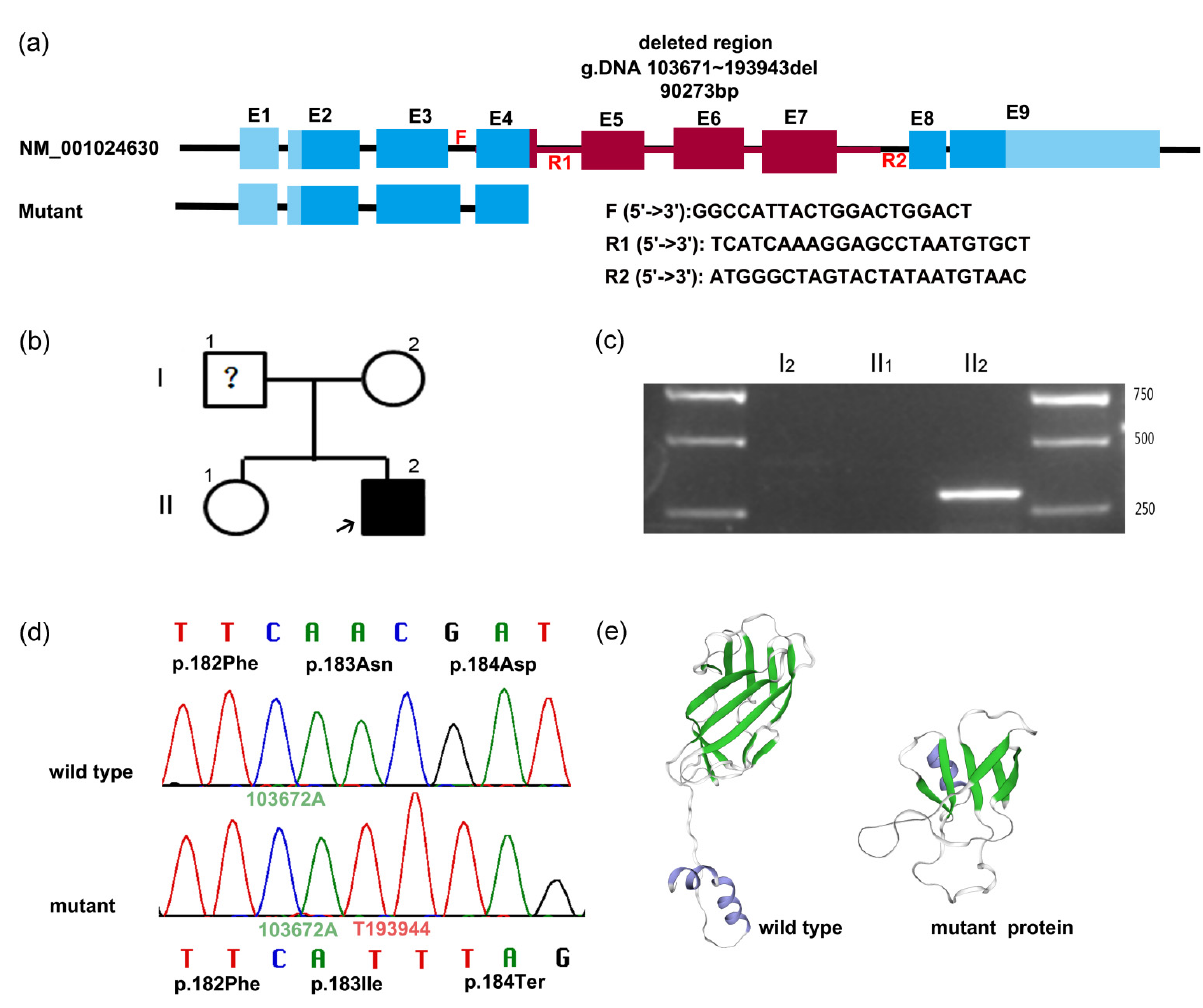
Figure 2. PCR and Sanger sequencing to determine mutation. ( a ) Schematic map of the deleted fragment and designed primer in RUNX2 gene. Exons were labeled as solid rectangles in blue or red. The red zone between exon 4 and intron 7 represents a 90-kbp nucleotide detection. The first and second pairs of primers are F/R1 and F/R2, respectively. ( b ) Pedigree map. Arrow indicates the proband. The clinical phenotype and genotype of I 1 is unknown and thus designated with question mark. ( c ) PCR result of RUNX2 analysis. A 302-bp PCR product of the proband using the second pair of primers (F/R2) was amplified in the proband, not in other family members of I 2 and II 1 , in which a 90574-bp fragment was supposed to be amplified. ( d ) Comparing the sequencing chromatograms around g.103672A (c.547A) of RUNX2 of the proband. The upper one and lower one were from (F/R2), respectively. In the wild-type chain ( upper ), g.103673A (green) was next to g.103672A (green); while g.193944T (red) was followed by g.103672A (green) in the mutant chain ( lower ). ( e ) Predictive 3D structures of the wild-type and mutant RUNX2 proteins using SWISS-MODEL. Green ribbon represents the β -sheet, and the blue ribbon represents α